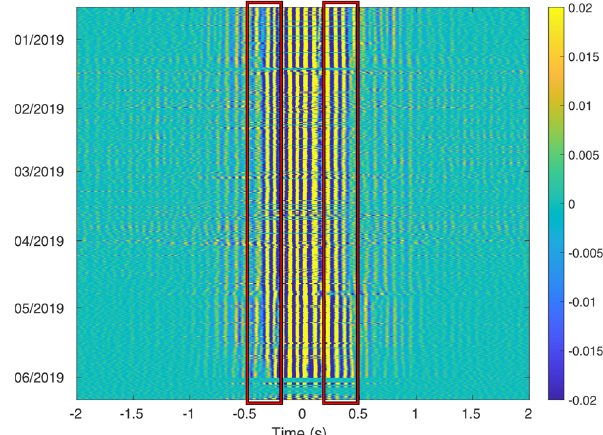
Figure 3. Filtered normalized correlogram from raw seismic noise cross-correlations over the pair of geophones used for the study. The time windows from which the d V/V values are estimated are localized by red boxes, corresponding to the direct (positive) and indirect (negative) coda part of the